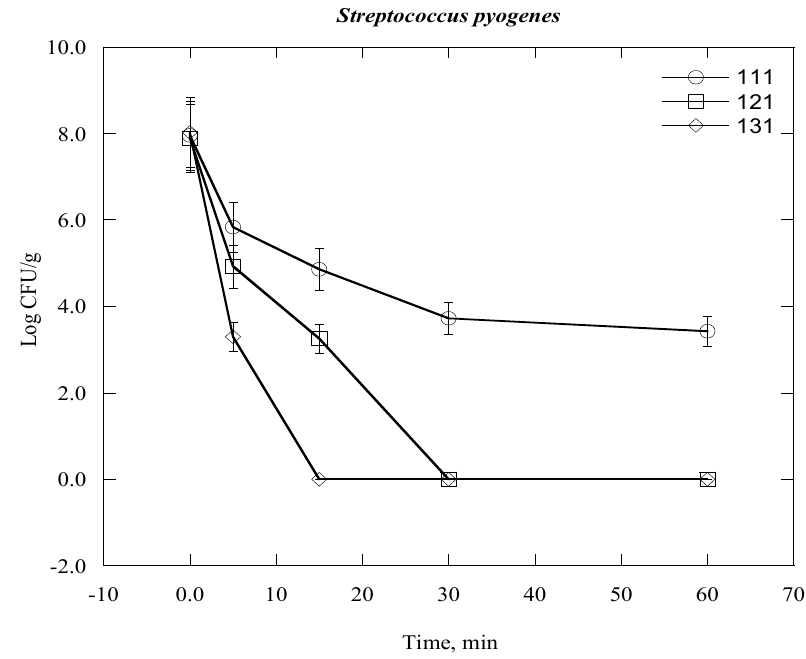
Figure 5. Inactivation of Streptococcus pyogenes in clinical solid waste using steam sterilization. Experimental conditions: (○), 111 °C (8 psi); (□), 121 °C (15 psi) and (◊), 131 °C (27 psi).